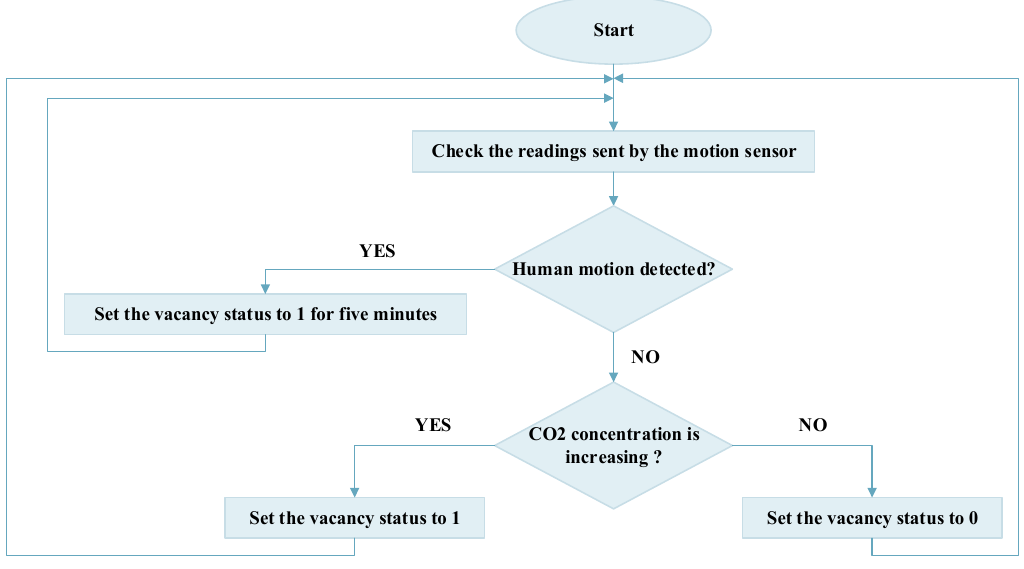
Figure 12. Room vacancy identification process.